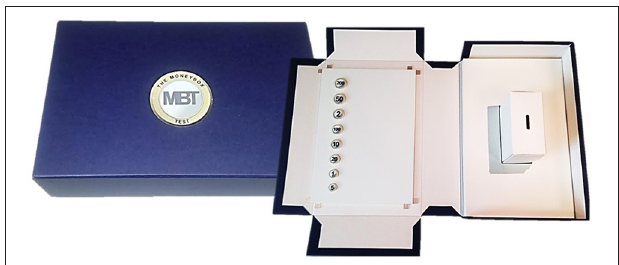
FIGURE 1 | The Moneybox test is enclosed in a case when not in use and when opened the contents required for testing are